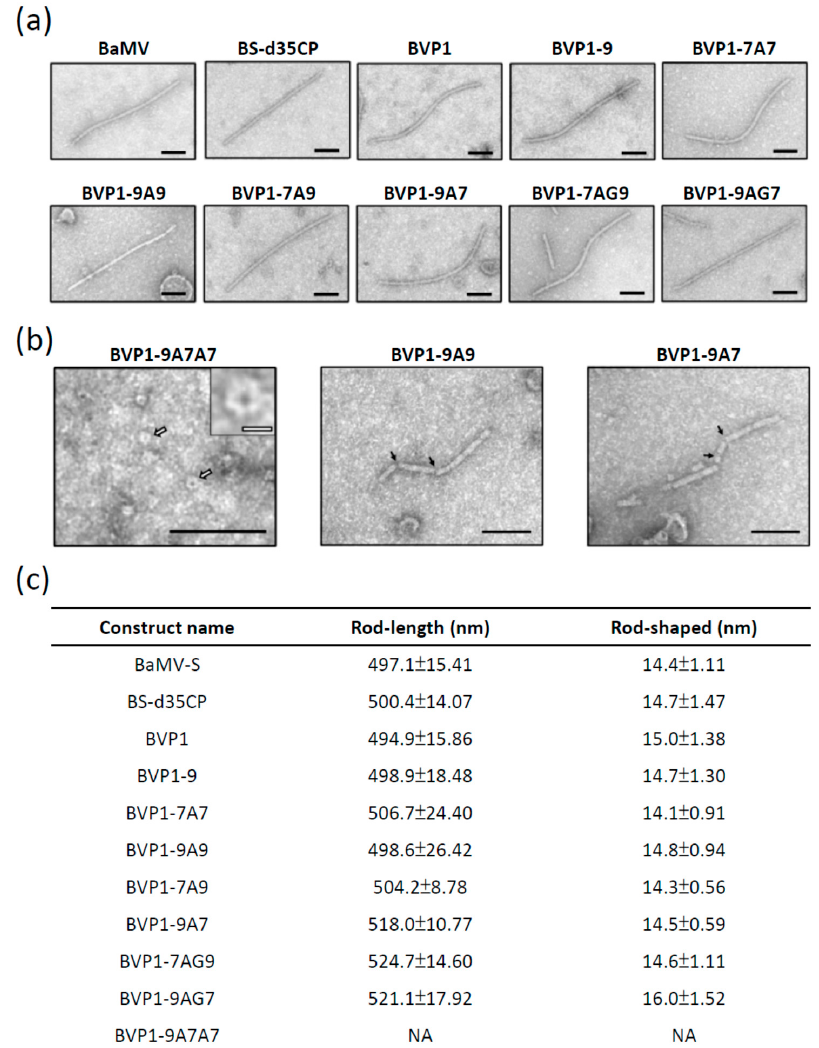
Figure 5. Transmission electron micrographs of negatively stained (UAc) BVP1s (various FMDV VP1 epitopes expressed on BaMV) particles. Serologically specific electron microscopy (SSEM) micrographs of BVP1s CVPs extracted from C. quinoa leaves inoculated with the chimeras indicated below the photographs. ( a ) Complete BVP1s virus particles, and ( b ) incomplete or abnormal BVP1s virus particles were detected by SSEM indexing using BaMV antiserum and subjected to examination by transmission electron microscopy. The magnification levels were 96,000× for BVP1 - 9A7A7 and 46,000× for the other samples. Inset BVP1 - 9A7A7 picture shows the same sample at higher magnification. White arrows represent disks and black arrows represent break points. The black scale bars represent 100 nm, and the white scale bar represents 10 nm. ( c ) The diameters and lengths of the corresponding virus particles. Numbers represent the mean diameters and lengths, respectively, calculated from 20 independent samples with standard deviation indicated. NA indicates not applicable.